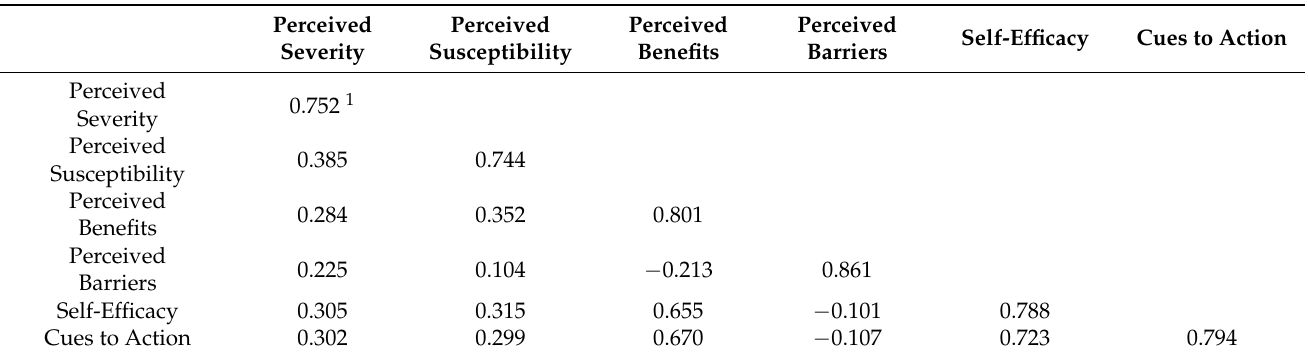
Table 5. Correlation matrix of HBM measures. (n = 898).